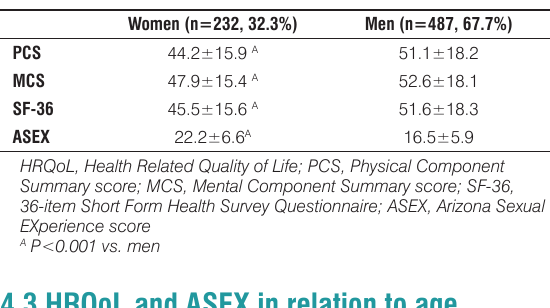
Table 3. Characteristics of HCWs.